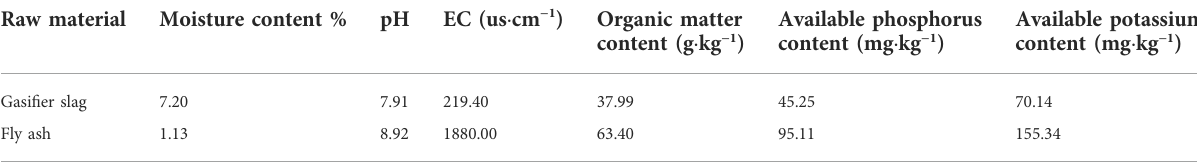
TABLE 2 Basic physicochemical characteristics of the raw materials.